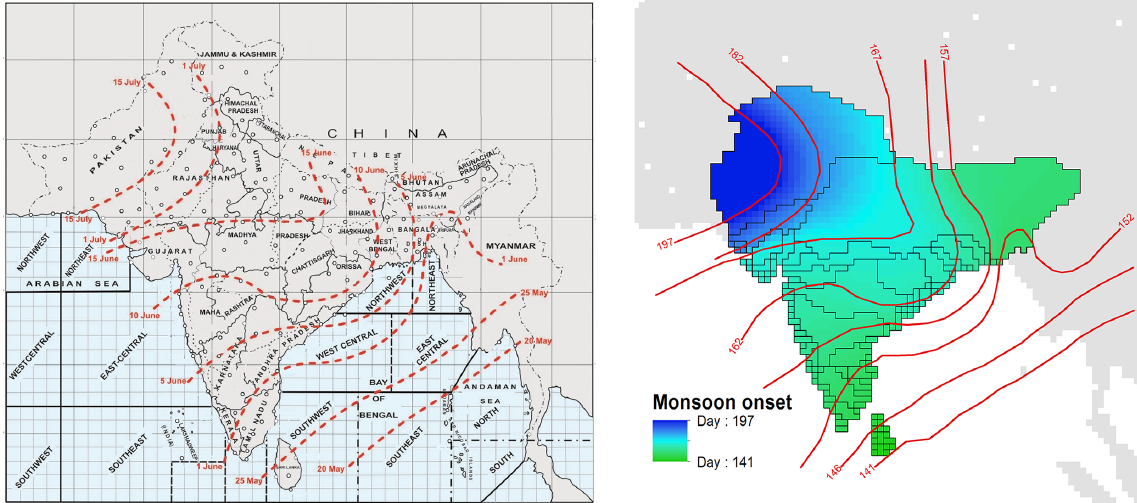
Figure 3. Normal dates for the onset of the south-west monsoon as presented by the Indian Meteorological Department (left panel) and inter- polated over South Asia (right panel) derive input data for LPJmL, red numbers indicating Julian days, grey lines showing basin